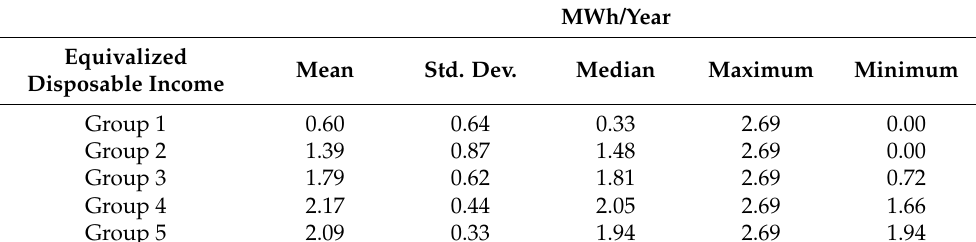
Figure 11. Mean energy consumption per household by group of cities without the influence of climate. Figure 12. Mean energy consumption per inhabitant by group of cities without the influence of climate.